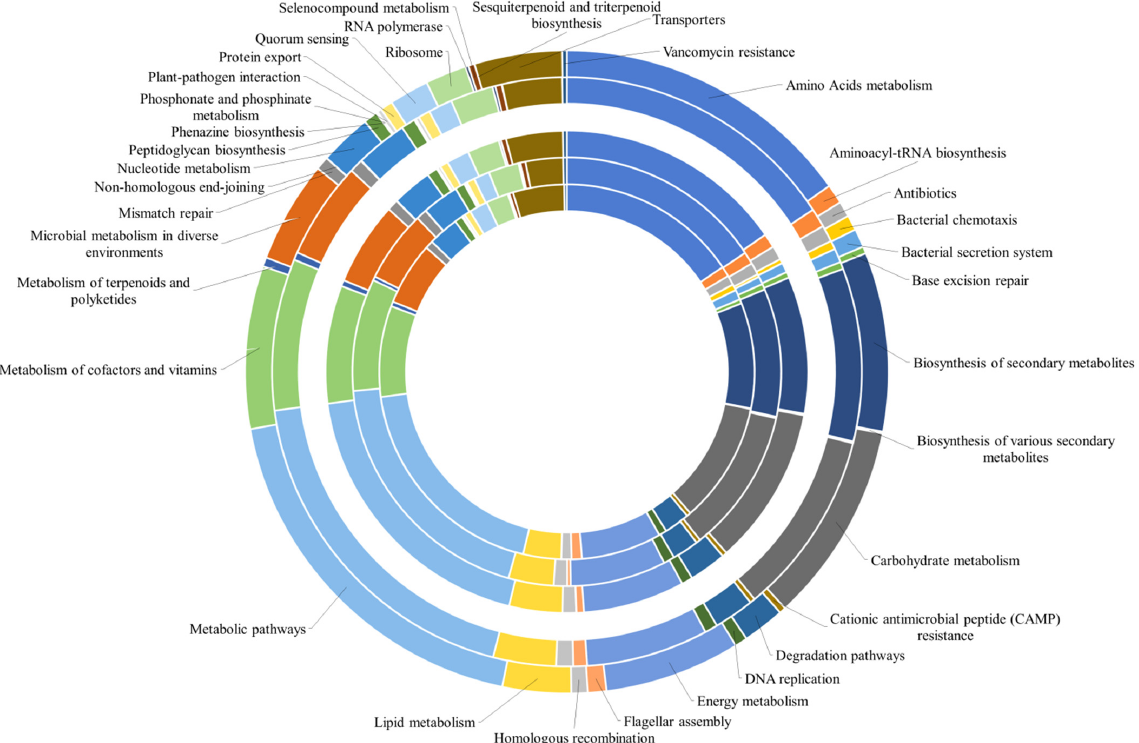
Figure 6. Relative abundance of predicted genes of the most abundant pathways identified in the bacterial and archaeal populations by the PICRUSt analysis. The pathways are presented according to KEGGs. Brines are in the order BC1 (as the innermost sample) → BC2 → BC3 → TF4 → TF5 (as the outermost